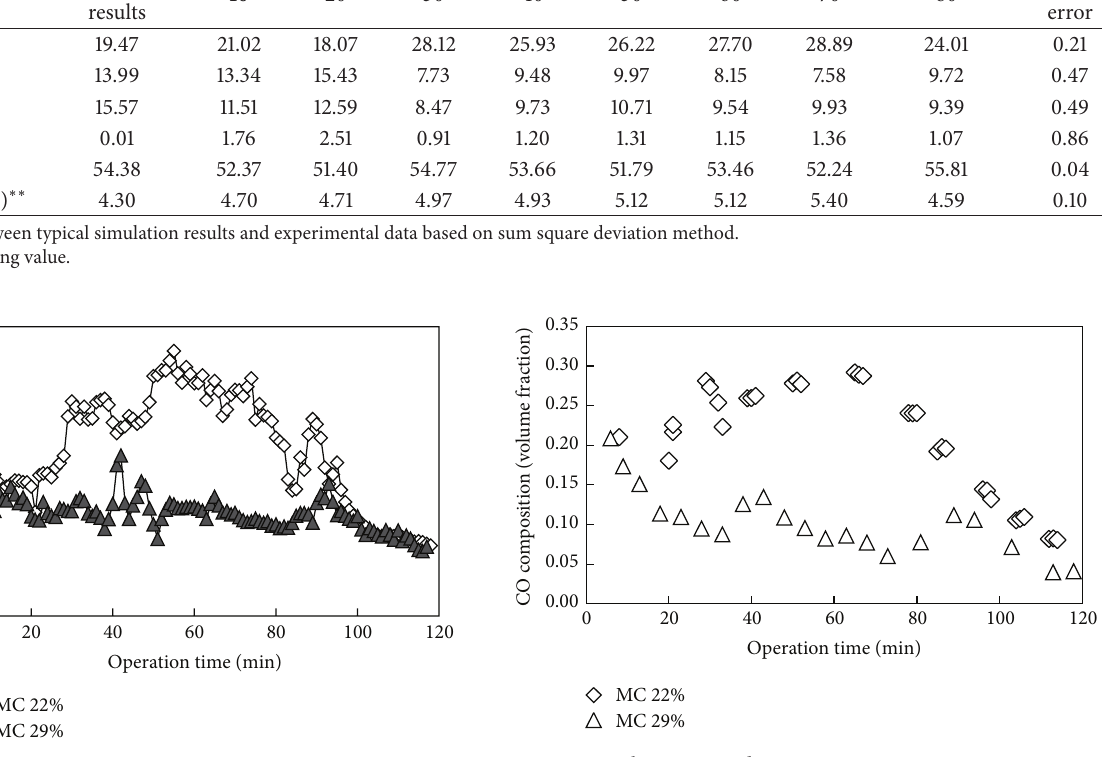
Figure 2: Dynamic temperature profiles of oxidation zone temper- ature for gasification of fuel with different initial moisture content.